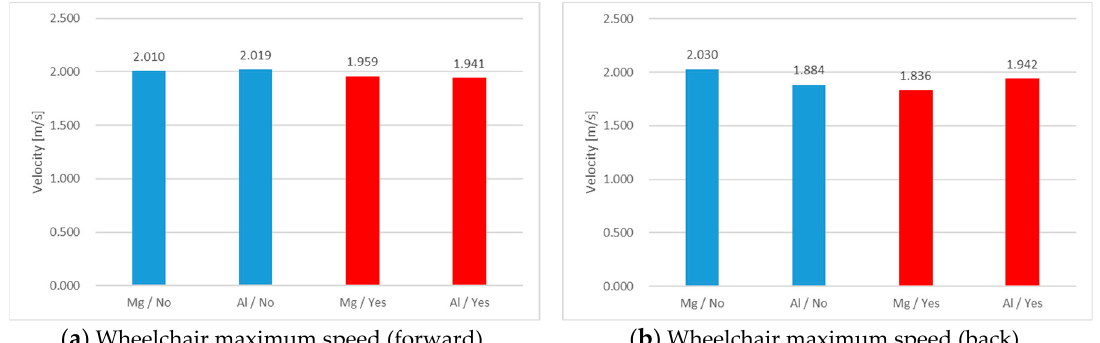
Figure 4. Wheelchair maximum speed. From the left of each figure, Mg alloy no racket, Al alloy no racket, Mg alloy racket, Al alloy racket: ( a ) forward stroke; ( b ) back stroke.